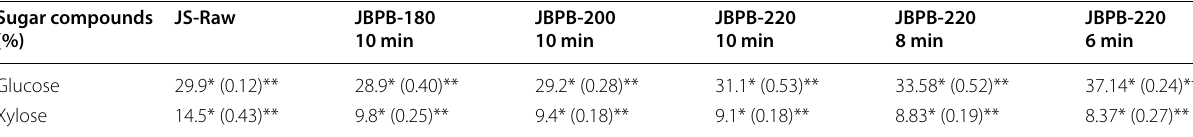
Table 4 Sugar contents of Jute stick and Jute Stick Binderless Particleboard (JBPB) pressed at different press temperatures and times